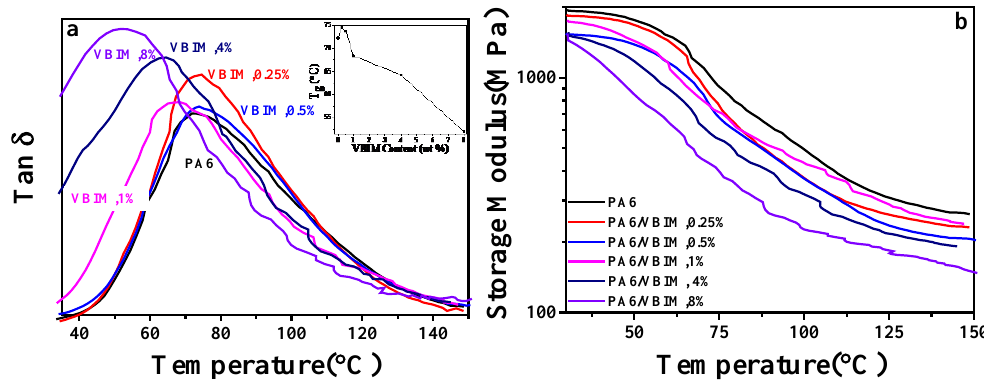
Figure 4. The loss tangent ( a ) and storage modulus ( b ) as functions of temperature for neat PA6 and the PA6/VBIM blends. The inserted sketch on the top right corner in Figure 4a shows how T g varies according to VBIM contents in the blends.